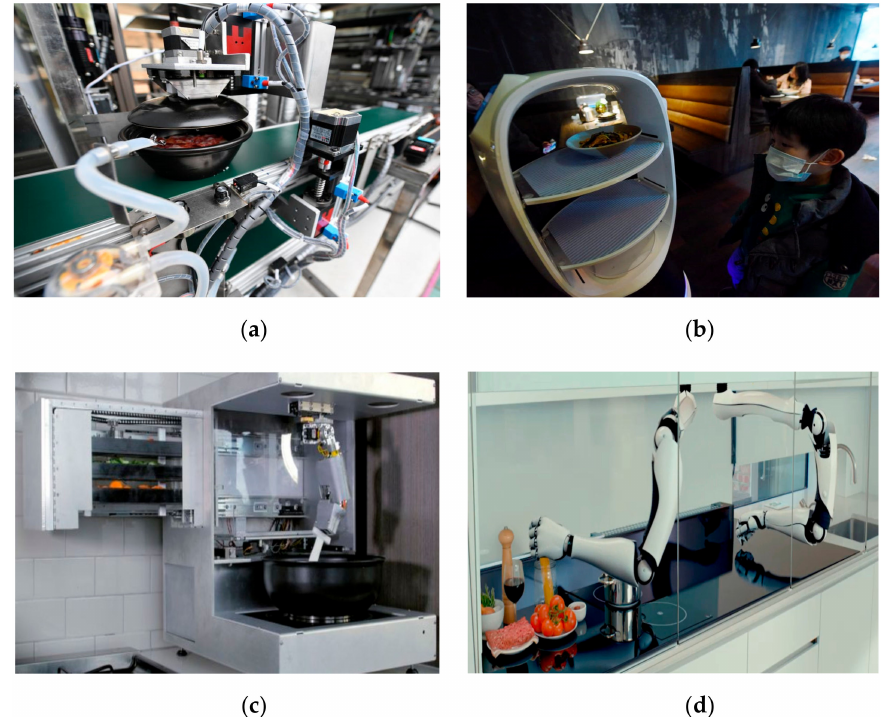
Figure 16. Food robots in a hospital’s kitchen for preparing and delivery. ( a ) Robot chef in a ( d ) Moley—World’s first robotic kitchen